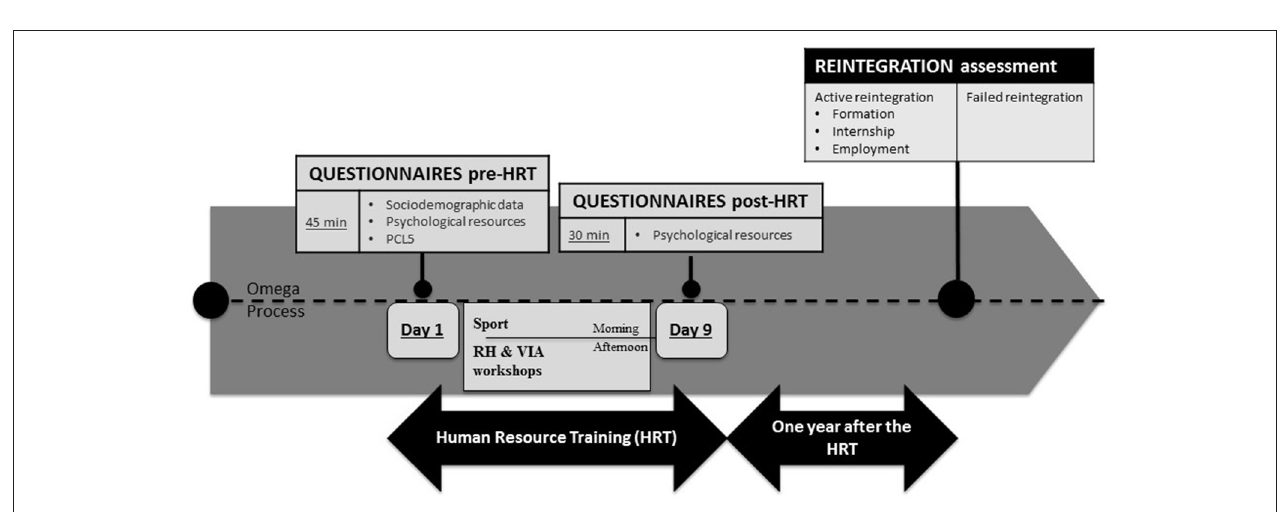
FIGURE 2 | Experimental protocol with the distribution of the three sessions: first day of the Human Resource Training (pre-HRT), the last day of the HRT (post-HRT), and 1 year after.